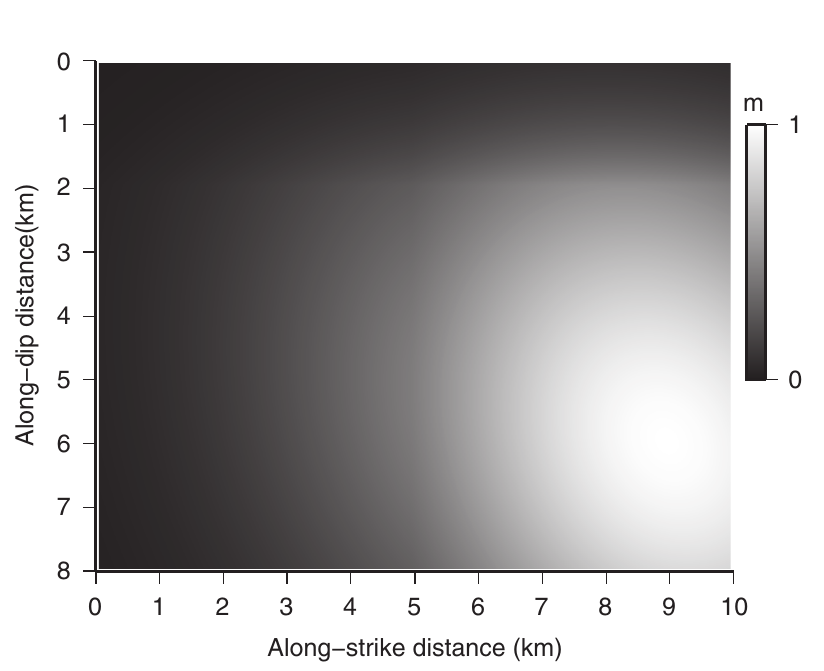
Fig. 1. Slip distribution on the source